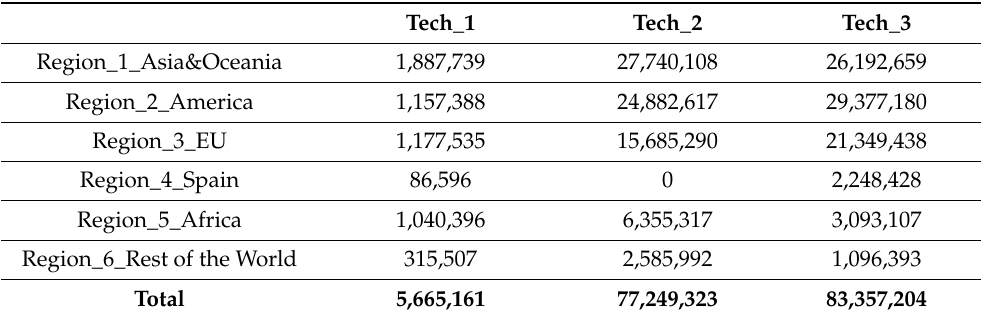
Table 8. Water split High, Medium, Low real world coefficients and water returns. Solution of x by region and technology (million